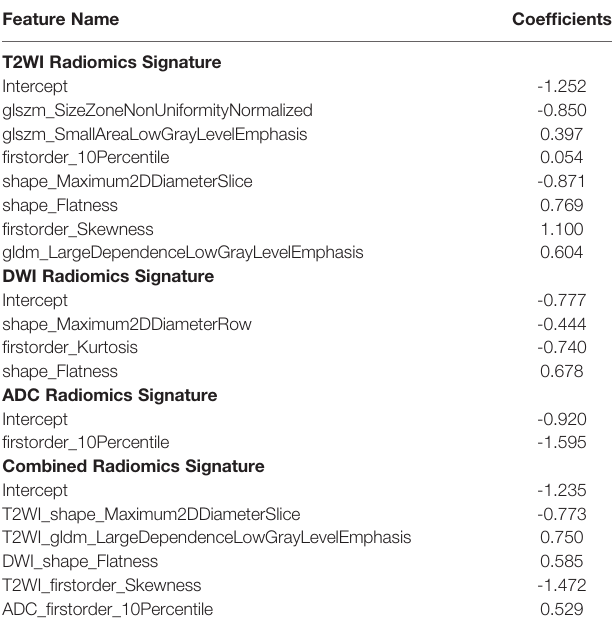
TABLE 3 | Features of T2WI, DWI, ADC, and Combined Radiomics Signatures. Feature Name